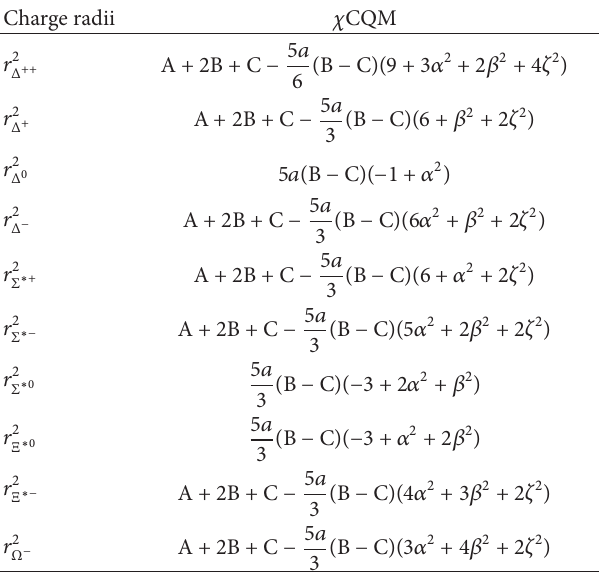
Table 4: Charge radii of decuplet baryons in 𝜒 CQM in terms of SU (3) symmetry breaking parameters and GPM parameters. These results are obtained by substituting 𝑞 → 𝑃 𝑞 𝑞 + |𝜓(𝑞)| 2 and 𝑞 ± → 𝑞 + |𝜓(𝑞 )| 2 for every constituent quark in NQM. 𝑃 𝑞 ± ± Charge radii 𝜒